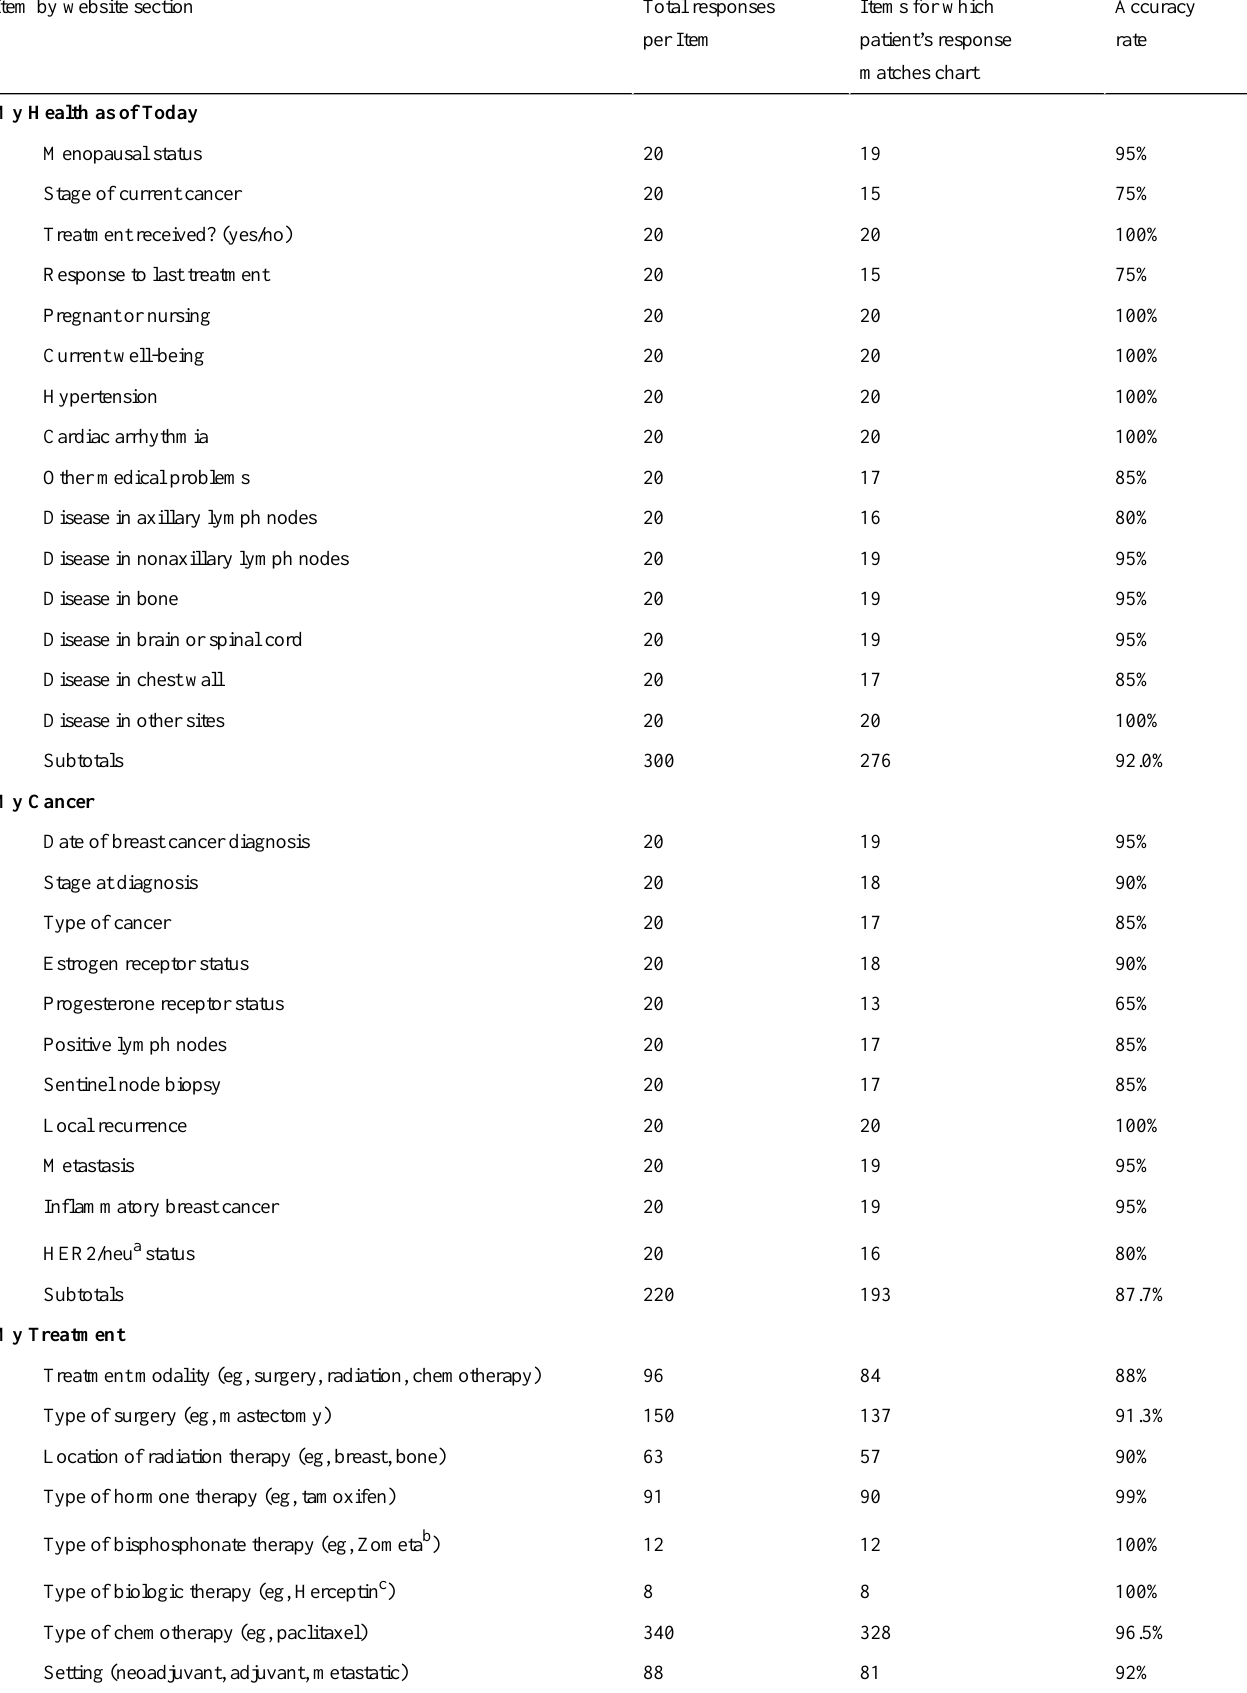
Table 3. Accuracy of patients’ responses to health history questionnaire items, compared with a study coordinator’s abstraction of the data from the patients’medical